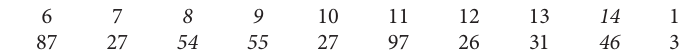
Table 2: The inventories of